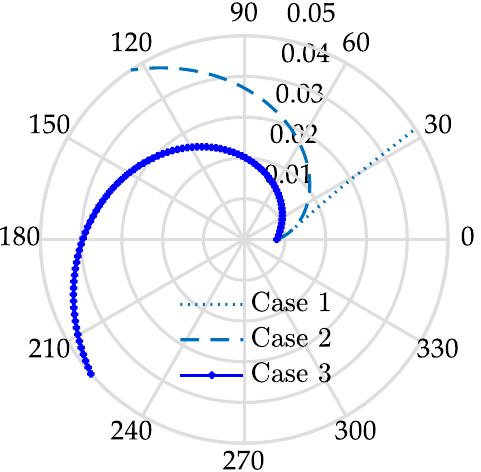
Figure 6. Pressure angle synthetic based on different cases.